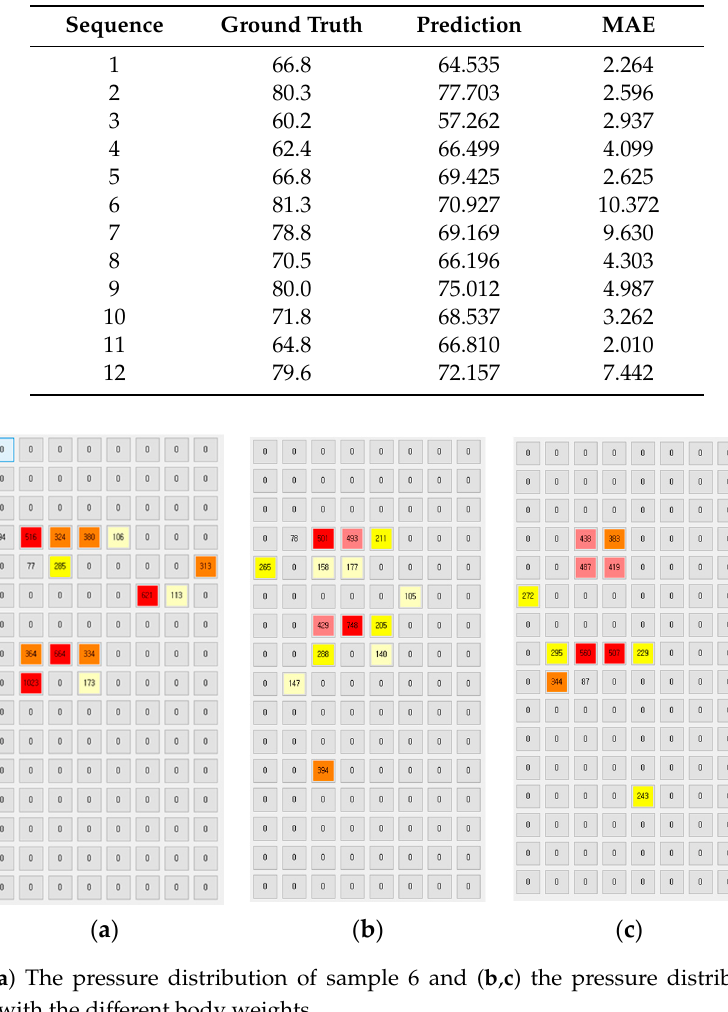
Table 6. Evaluation of the proposed method using validation dataset.